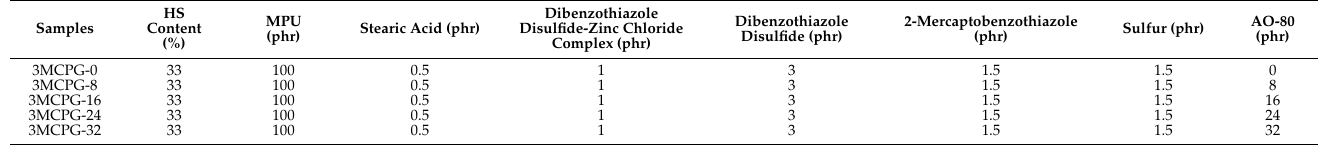
Table 4. Formulations of the MPU/AO-80